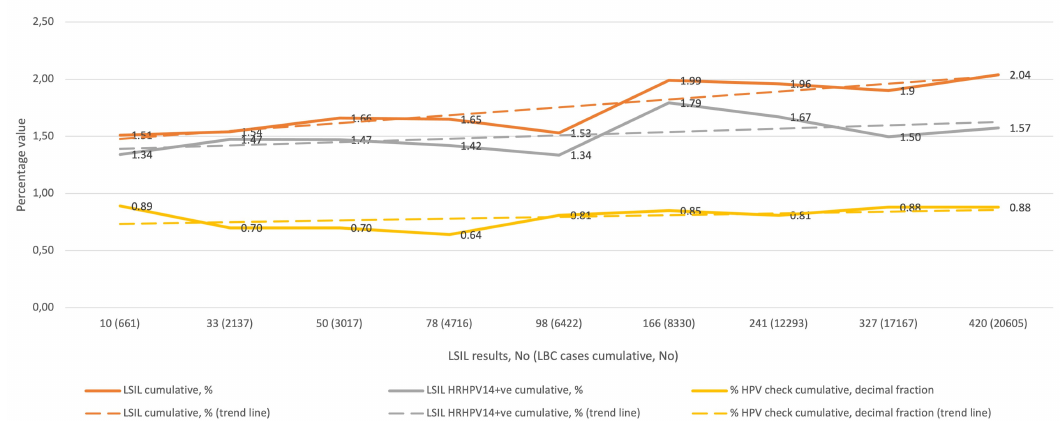
Figure 2. QC results for LSIL in the study period (1–9 rounds). Abbreviations: QC, quality control; LSIL, low-grade squamous intraepithelial lesion; LBC, liquid-based cytology; HRHPV14, 14 high-risk types human papillomavirus test; +ve; positive; HPV, HRHPV14.